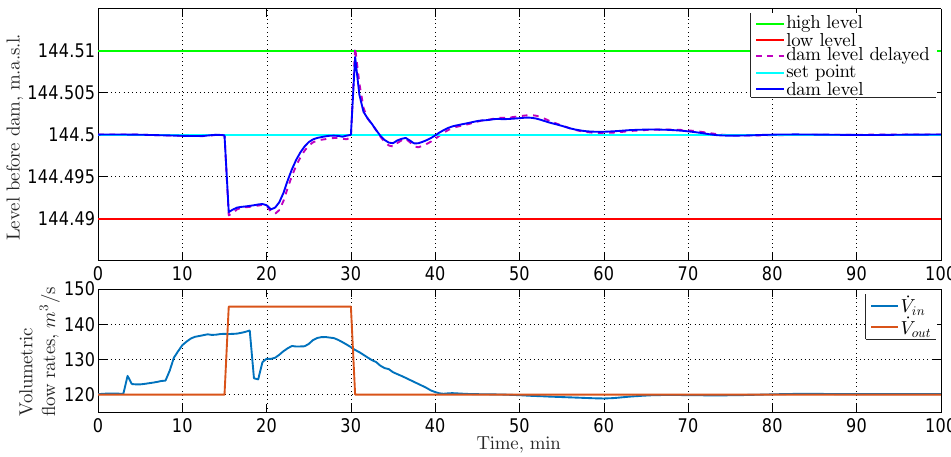
Figure 18: Comparison of instantaneous and delayed control signal from MPC, where the inlet flow rate is a control